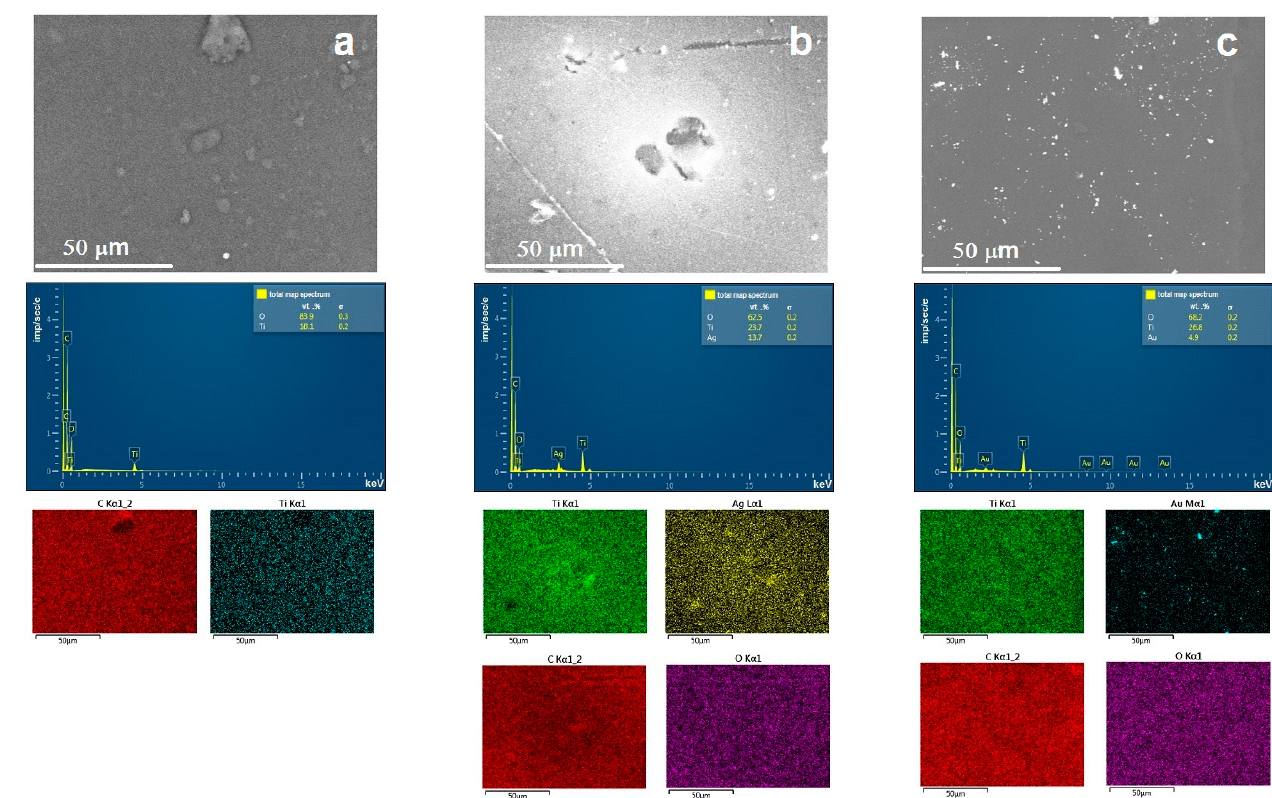
Figure 2. Elemental surface composition of nanocomposites [( ≡ TiO) n ]:[HEMA]:[AN]: ( a ) without nanoparticles; ( b ) with Ag NPs; ( c ) with Au NPs.